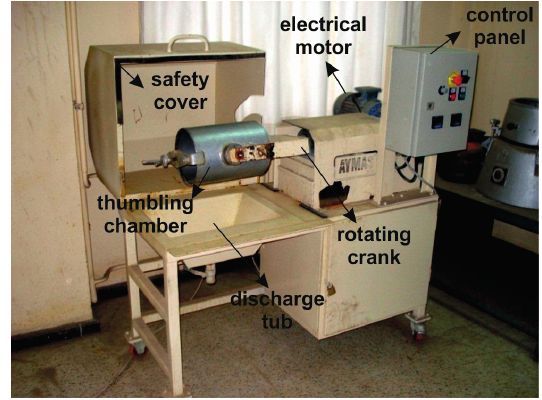
Figure 3. Laboratory type rod mill used as autogenous tumbling mill.